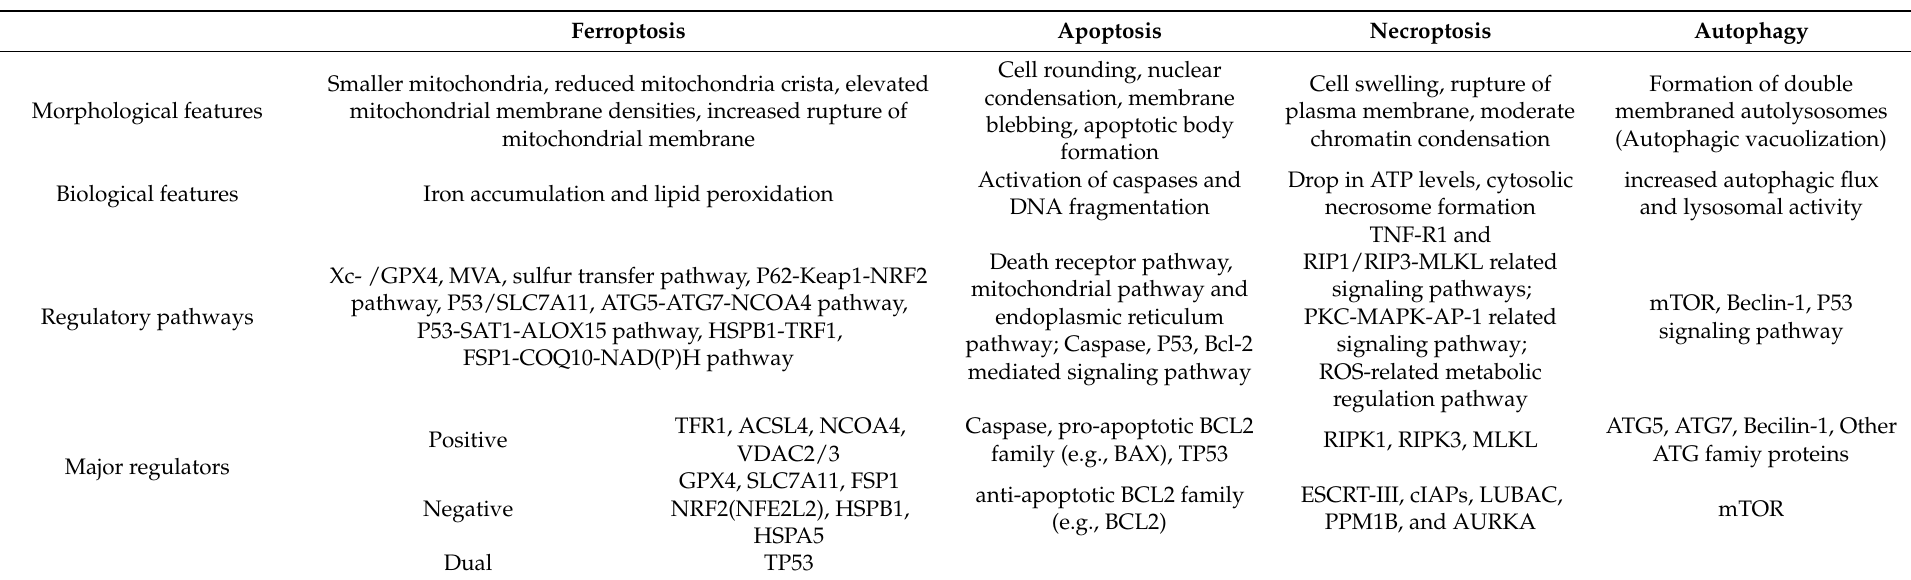
Table 1. The characteristics of ferroptosis and other type of RCD (modified from 4, 11,